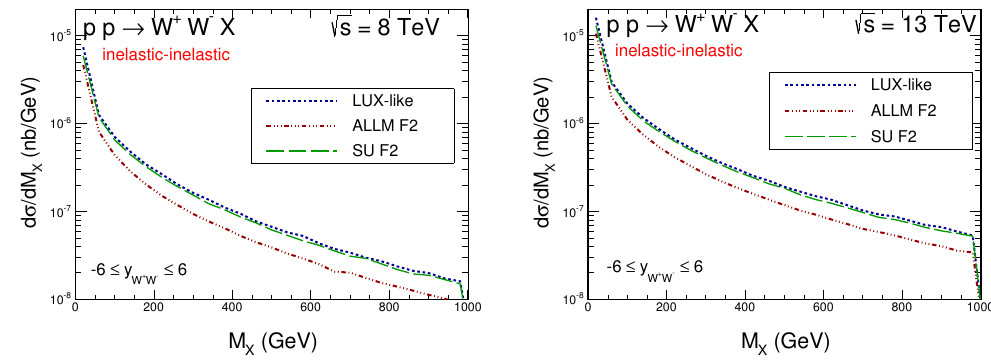
Figure 6 . Missing mass distributions for inelastic-inelastic photon-photon contributions for dif- ferent parametrizations of the structure functions as explained inside the (cid:12)gures for two energies: p p s = 8 TeV (left panel) and s = 13 TeV (right panel).